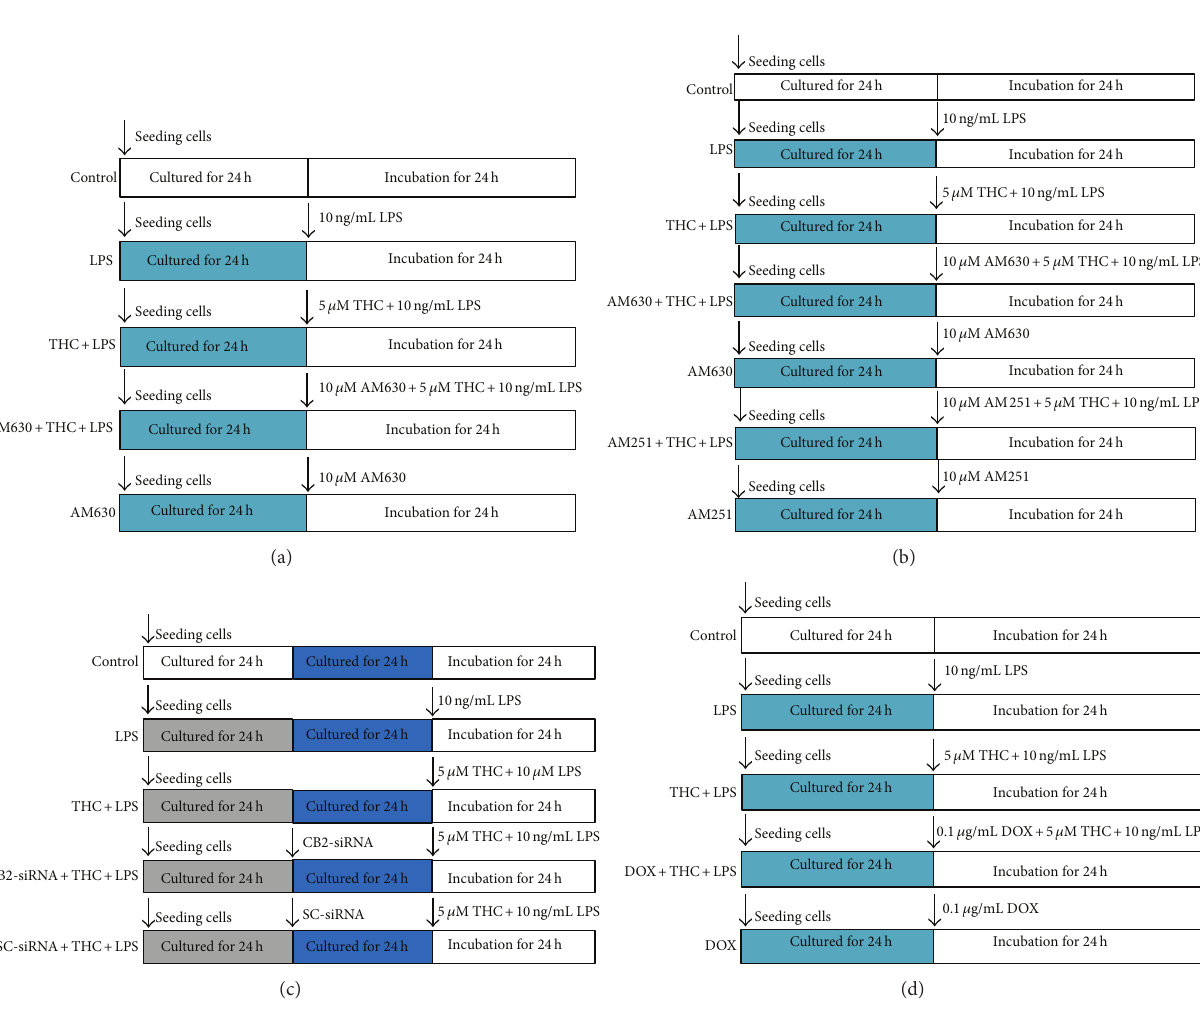
Figure 1: Experimental protocol diagram. (a) The MG-63 cells were assigned into five groups, including control, LPS, THC + LPS, AM630 + THC+LPS,andAM630groups.Afterthetreatmentsfor24h,immunocytochemistryandwesternblotweretakentoinvestigatetheexpression of CB2 receptor. (b) The MG-63 cells were assigned into seven groups as shown in this figure. After the treatments, ELISA was used to evaluate the inflammatory factors concentrations in the supernatants. (c) The MG-63 cells were assigned into five groups, including control, LPS, THC + LPS, CB2-siRNA + THC + LPS, and SC-siRNA + THC + AM630 groups. After the treatments, western blot was taken to investigate the expression of CB2 receptor and ELISA was used to assess the inflammatory factors release. (d) The cells were divided into control, LPS, THC + LPS, doxycycline (DOX) + THC + LPS, and DOX groups, western blot was taken to investigate the expression of cofilin-1 protein, and ELISA was taken to evaluate the concentrations of proinflammatory factors in the